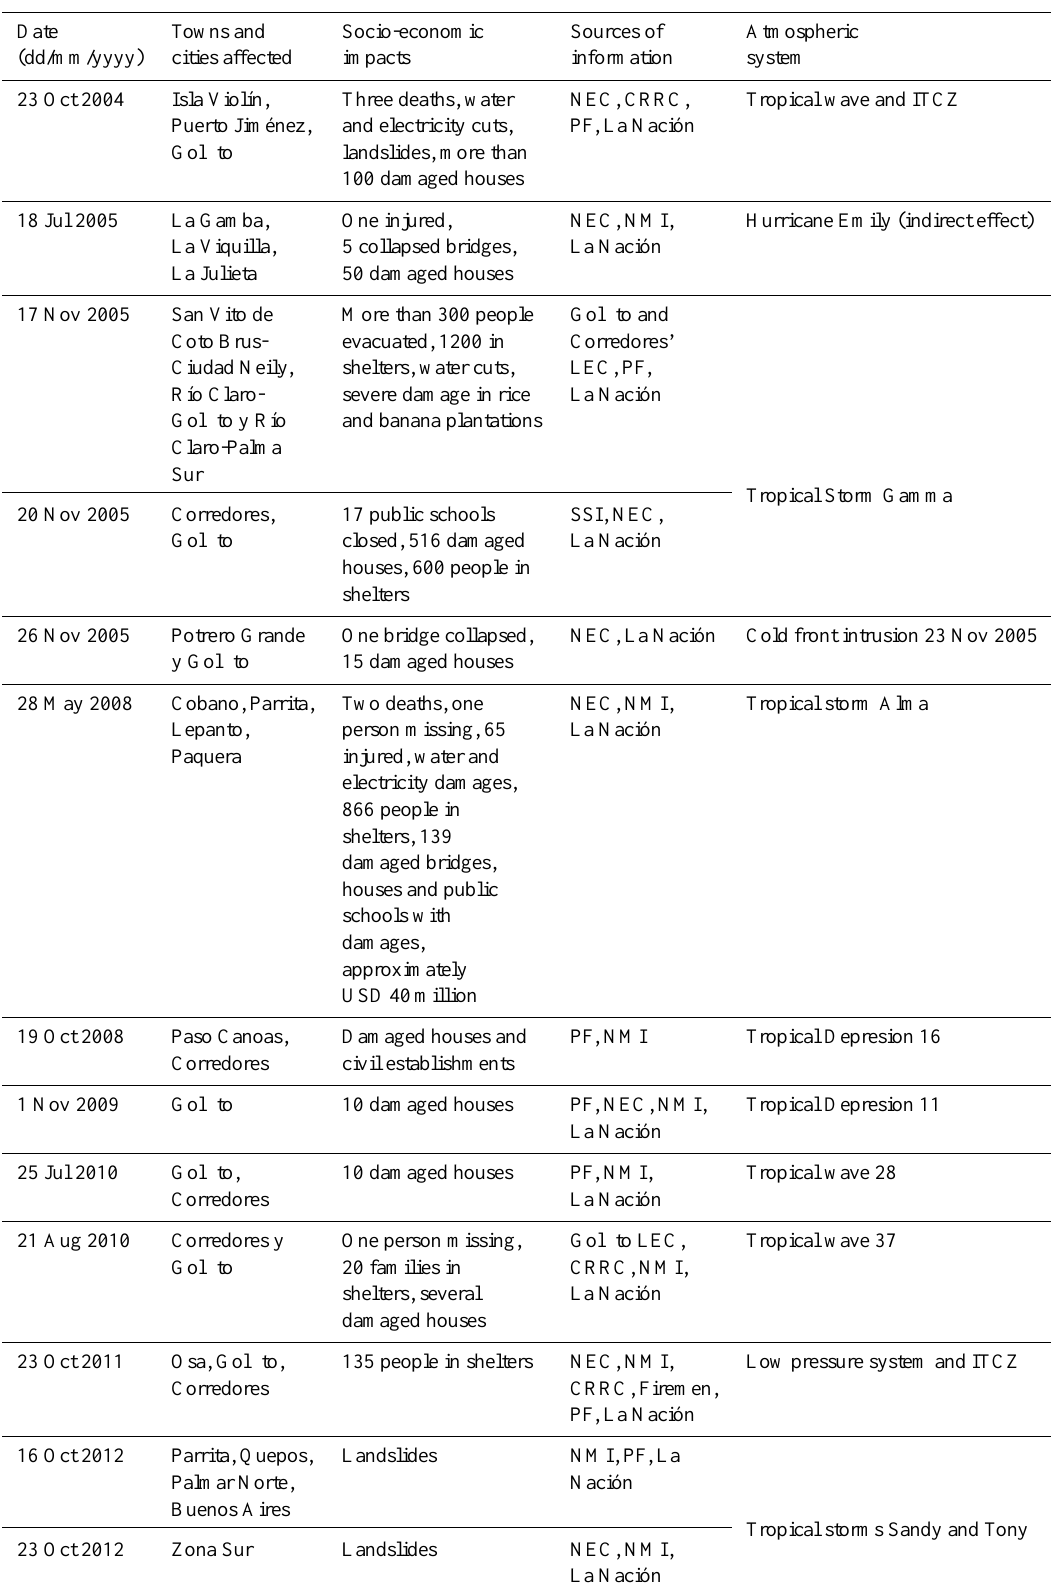
Table 2. Socio-economic impacts due to hydro-meteorological activity during the period 2002–2012 in the south Pacific slope of Costa Rica according to press